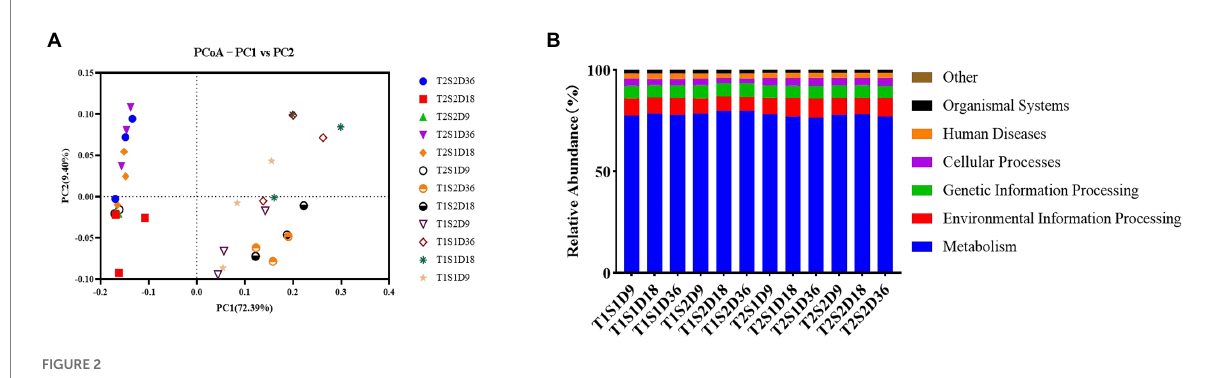
FIGURE 2 PCoA analysis (A) and Functional gene prediction (B)